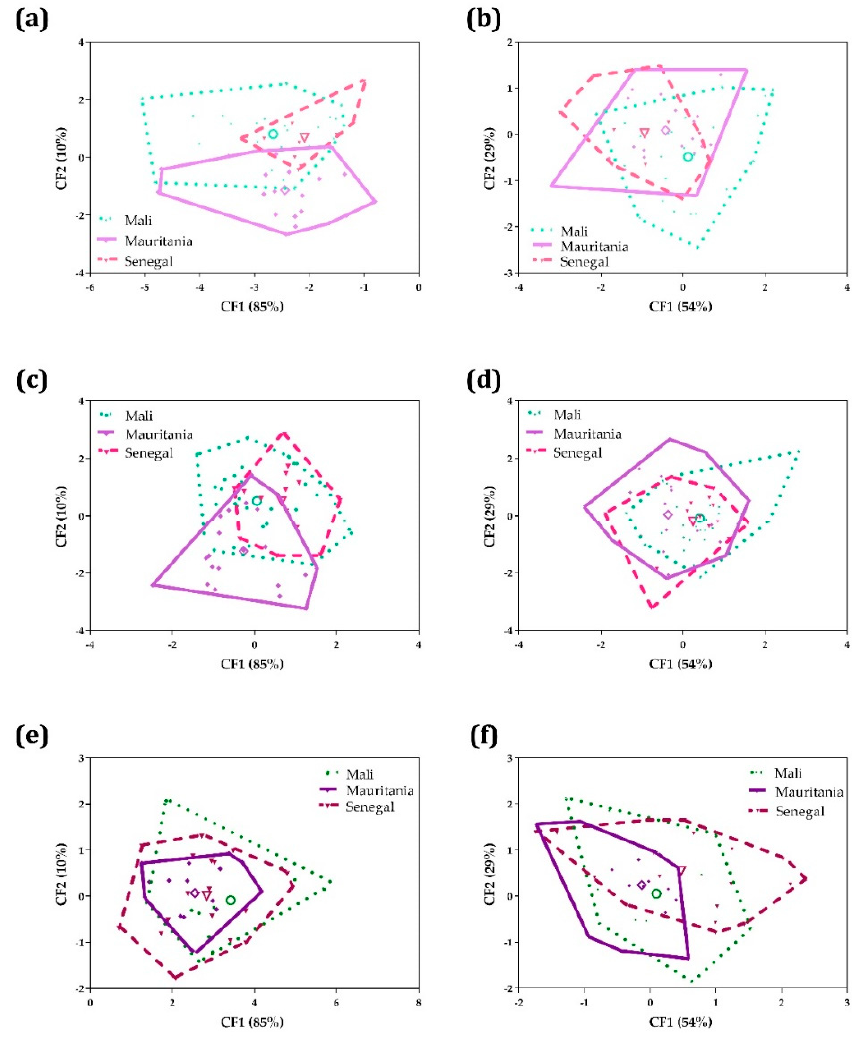
Figure 7. Factor map corresponding to S. haematobium eggs shed by individuals from Mali, Mauri- tania and Senegal: ( a ) analysis of all measurements of the round phenotype; ( b ) analysis of spine measurements of the round phenotype; ( c ) analysis of all measurements of the elongated phenotype; ( d ) analysis of spine measurements of the elongated phenotype; ( e ) analysis of all measurements of the spindle phenotype; and ( f ) analysis of spine measurements of the spindle phenotype. Each group is represented by its perimeter. In order to facilitate the comparison between countries, each morphotype is displayed separately, but graphs ( a , c , e ) and ( b , d , f ) come from the same CVA analysis, respectively. Dotted line: Mali; solid line: Mauritania; dashed line: Senegal. Circle: Mali centroid; square: Mauritania centroid; triangle: Senegal